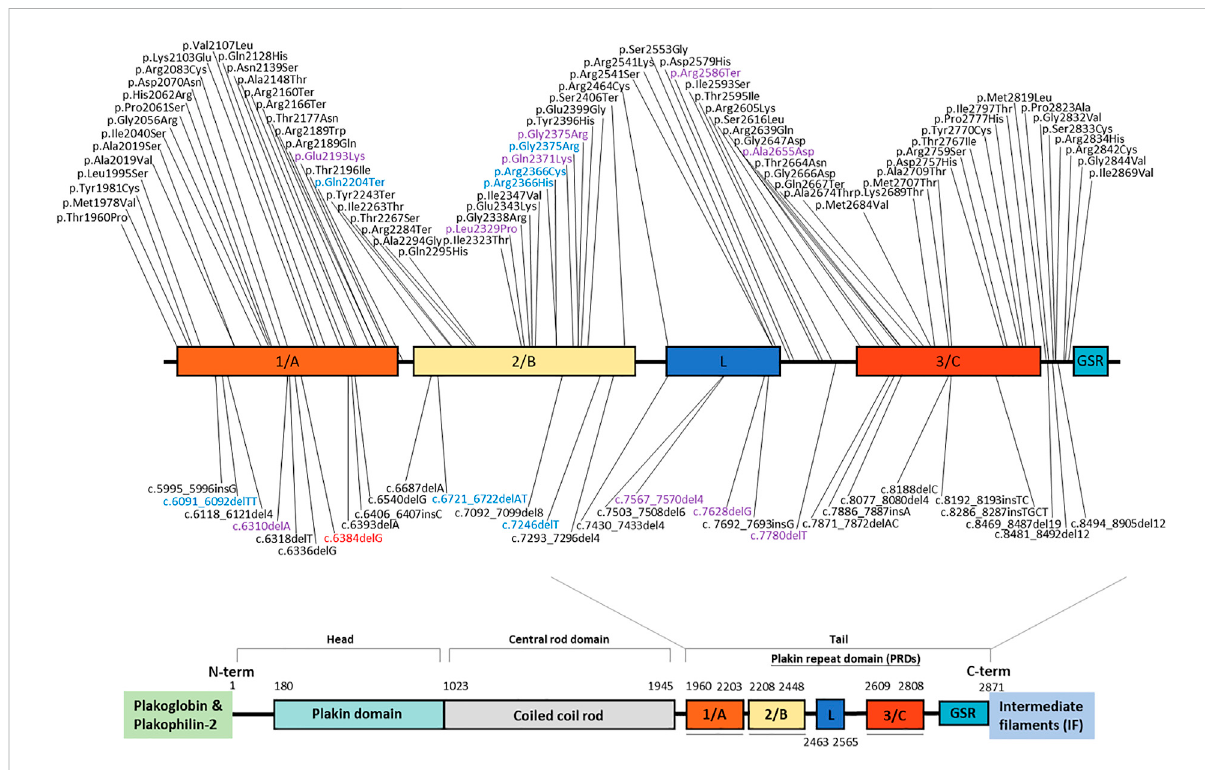
FIGURE 2 Schematic of desmoplakin protein domains labeled with reported mutations within the tail domain. The mutation identi fi ed in our study is marked in red. Mutations with different colors account for different phenotypes (black: heart only; blue: skin only; purple: heart and skin). Variants above the schematic are missense or nonsense mutations; those below the schematic are indel